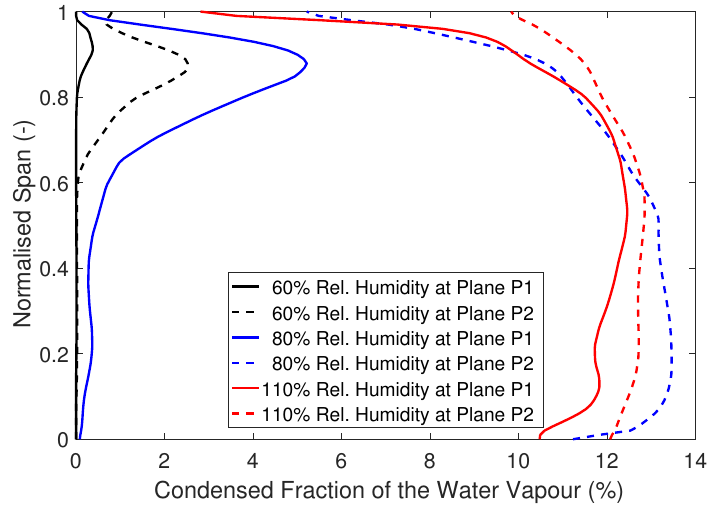
Figure 6. Condensed fraction of the water vapour downstream of the rotor. Figure 7 gives a contour plot of the static temperature in plane P1. The plot is divided into three sections showing, from left to right, the results for the cases with 60%, 80% and 110% humidity. A comparison of the cases of 60% and 80% relative humidity reveals a significantly warmer tip vortex system for the latter. This is due to the above mentioned increased condensation in the tip vortex system. The 110% relative humidity case shows a strongly increased temperature over the whole cross section due to condensation